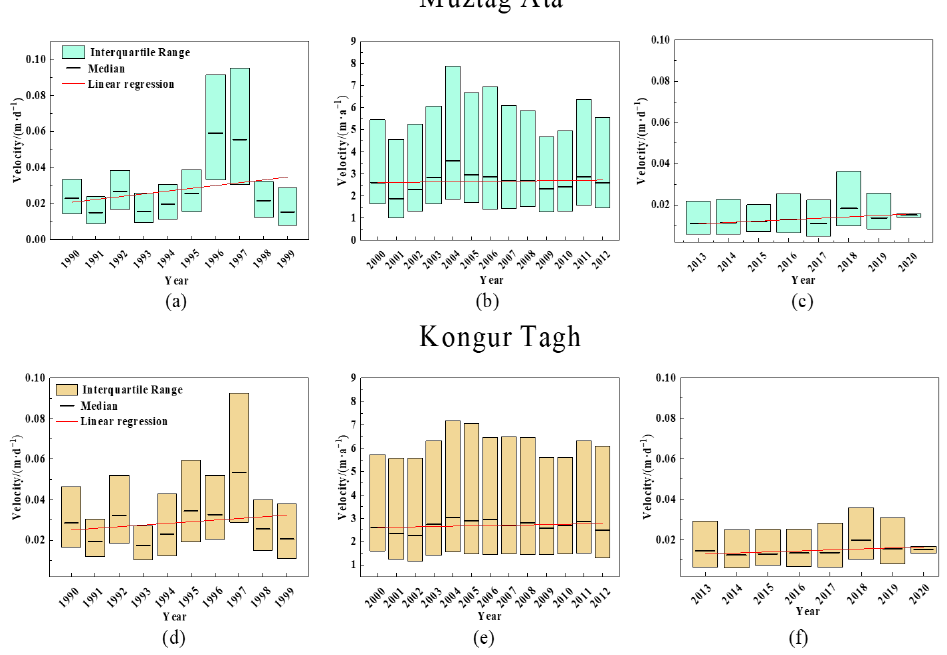
Figure 5. Inter-annual glacier velocity in the Muztag Mountains in ( a ) 1990–1999, ( b ) 2000–2012, and ( c ) 2013–2020, and in the Kongur Mountains in ( d ) 1990–1999, ( e ) 2000–2012, and ( f ) 2013 – 2020.